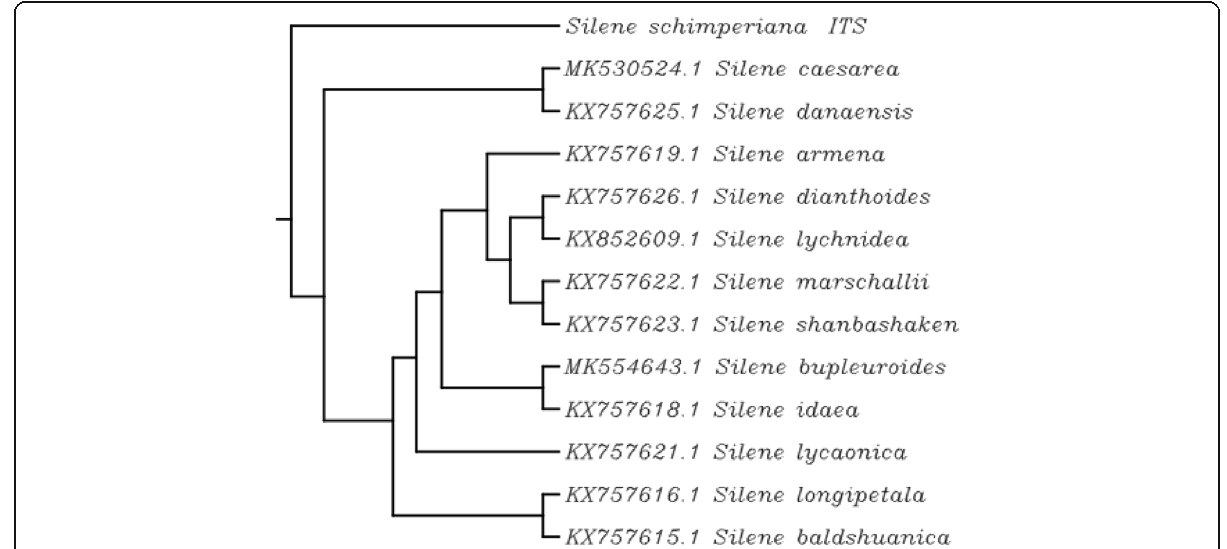
Fig. 4 Phylogenetic tree of Silene schimperiana using the ncDNA: internal transcribed spacer ( ITS